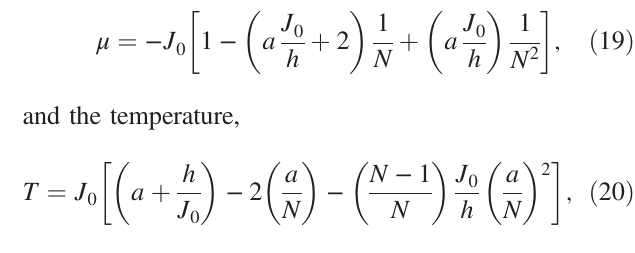
FIG. 2. An example (a) of a time-averaged nodal power h a R ( 1 = ð t − t ) t j ψ n ð t Þj 2 dt and (b) of a supermode power R min Þ t min t hj C α j 2 i ¼ ( 1 = ð t − t min Þ ) j C α ð t Þj 2 dt . In these simulations t t min the photonic network consists of N ¼ 8 nodes, J 0 ¼ 1 . 2 and σ ¼ 0 . Notice that the α ¼ 1 mode (red line) is separated from the ≈ 5 . 6 . The initial preparation rest, saturating at a value of hj C α j 2 i t has averaged energy density h ≈ − 0 . 61 and optical power a ¼ 1 . The nonlinearity parameter is χ ¼ 0 . 01 . The initial time is t 1000 in both